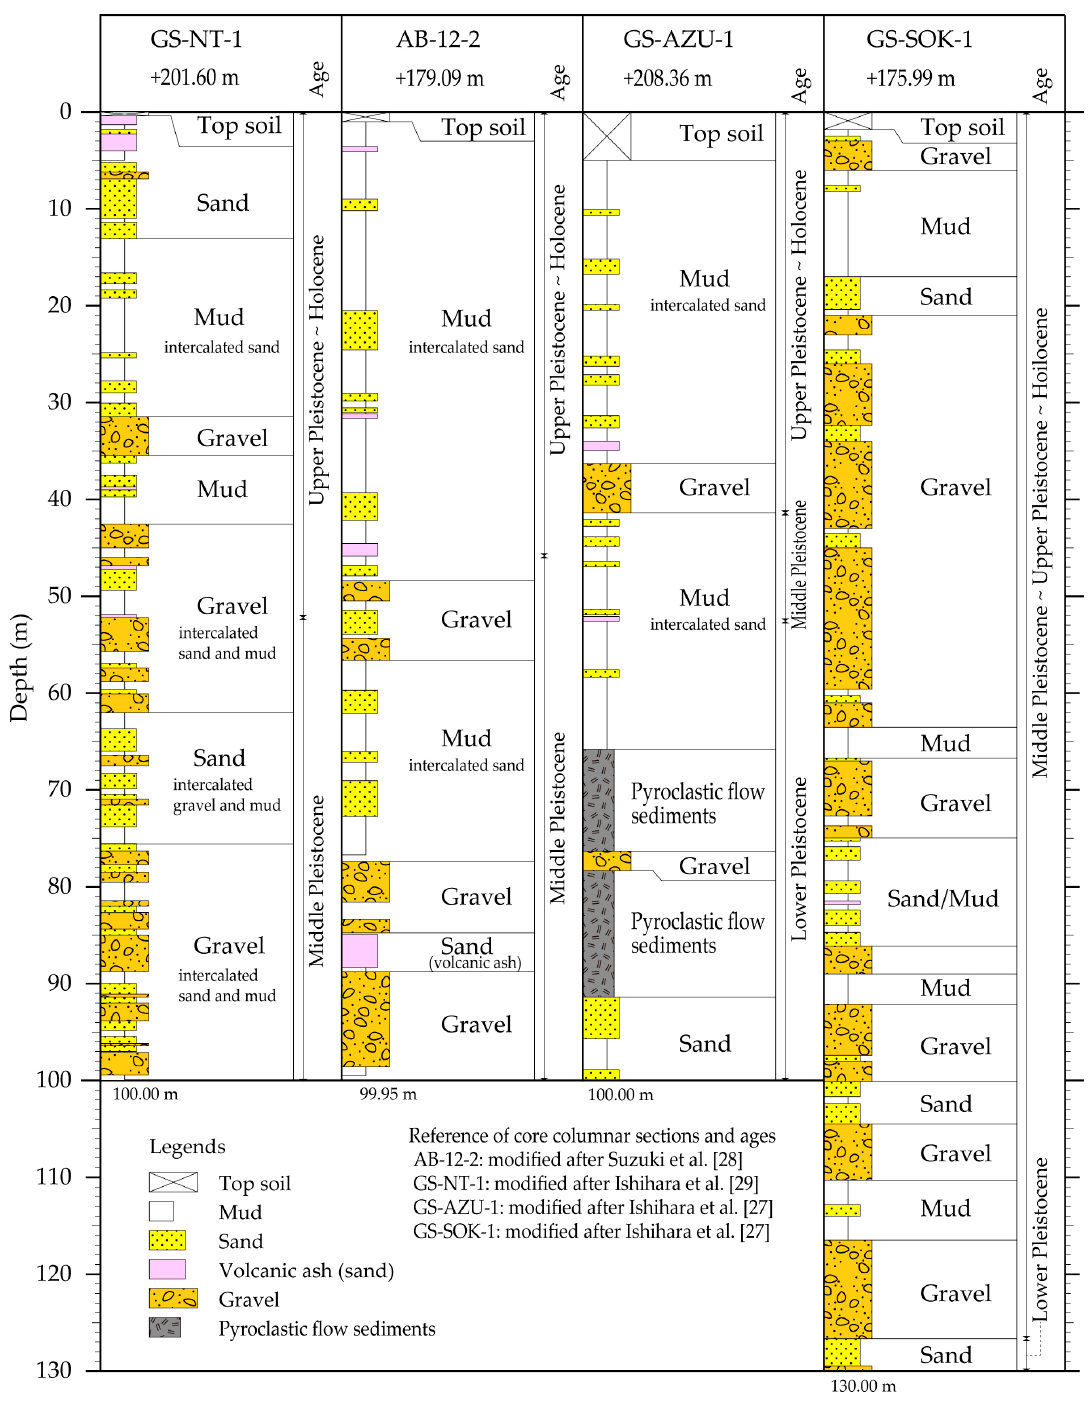
Figure 2. Stratigraphic columns of cores drilled in the Aizu Basin. Drilling sites are shown in Figure 1.